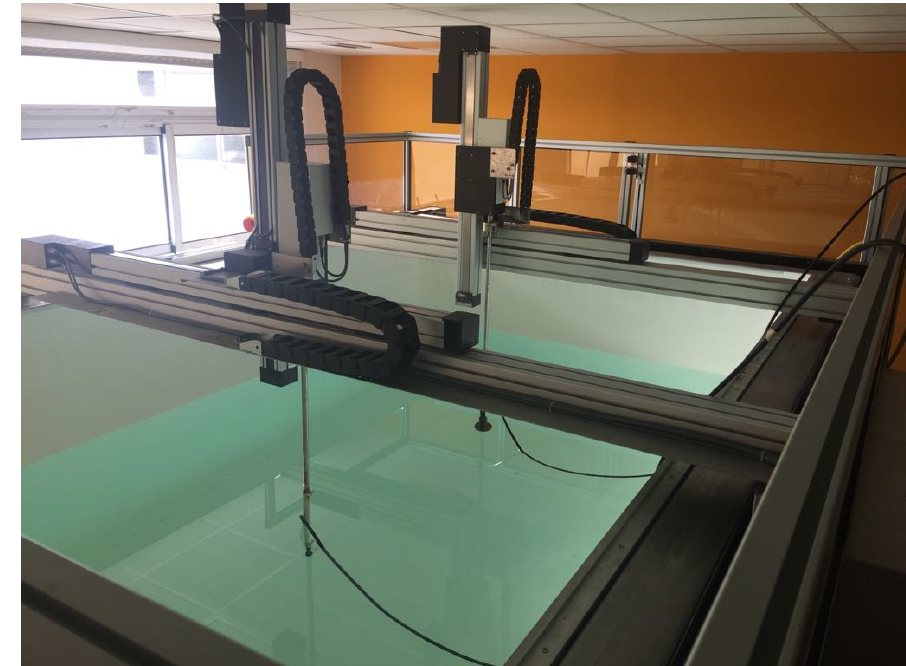
Figure 3. Experimental water tank.